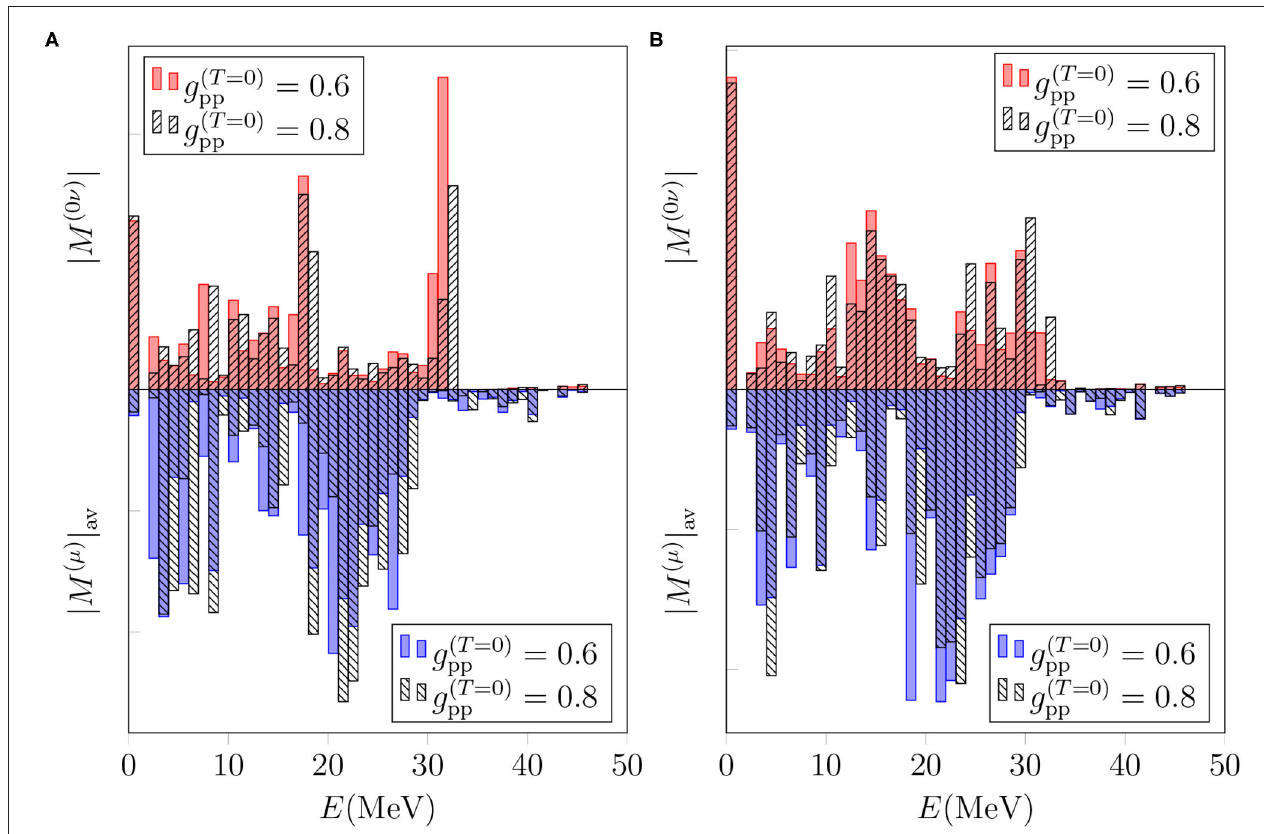
FIGURE 8 | Dependence of the energy distributions of the 0 νβ + β + -decay and OMC matrix elements for the J π = 2 + multipole on the particle-particle parameter g ( T = 0) pp in different bases. The OMC matrix elements are computed assuming the exact Dirac wave functions for a finite nucleus with uniform charge distribution. (A) Basis: “Adj.”. (B) Basis: